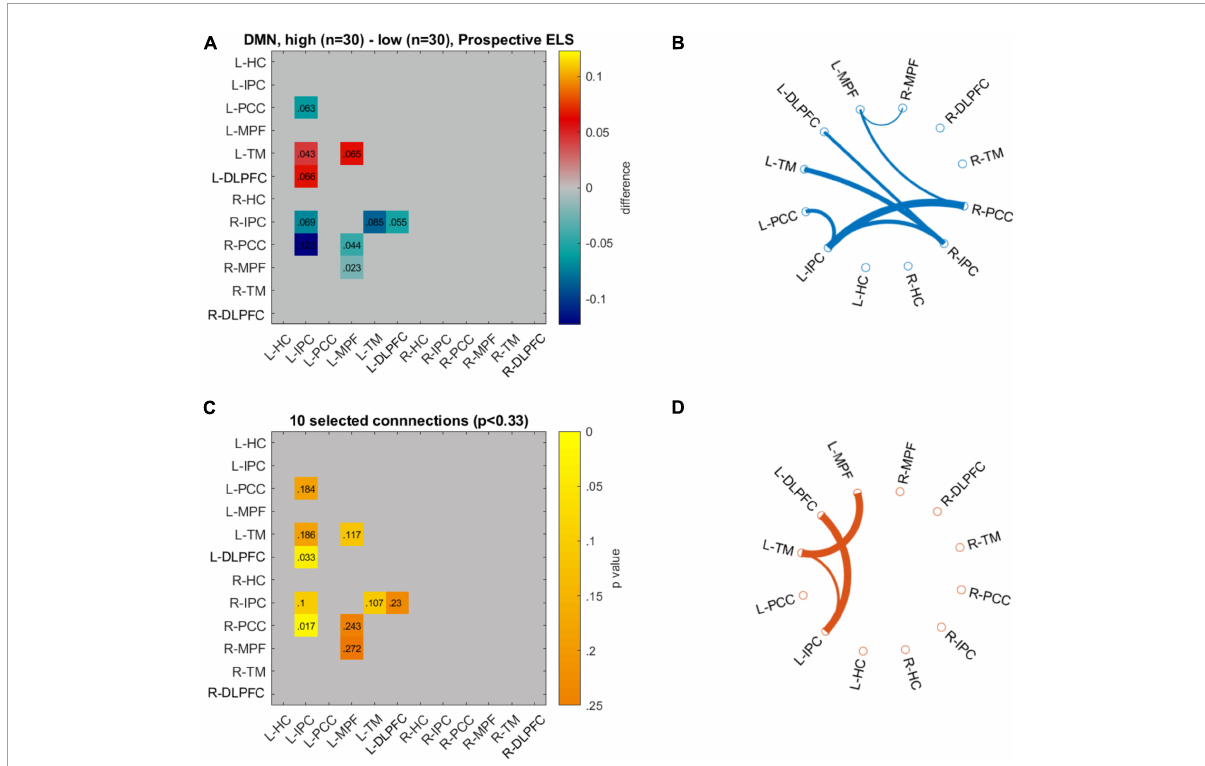
FIGURE5 Differences in network connectivity between participants with highest ( n = 30) and lowest ( n = 30) prospective ELS values are plotted as mean difference (A) and 10 connections with the lowest p -values (C) . Circulographs of the negative ( B ; high prospective ELS → reduced connectivity) and positive ( D ; high prospective ELS → increased connectivity)